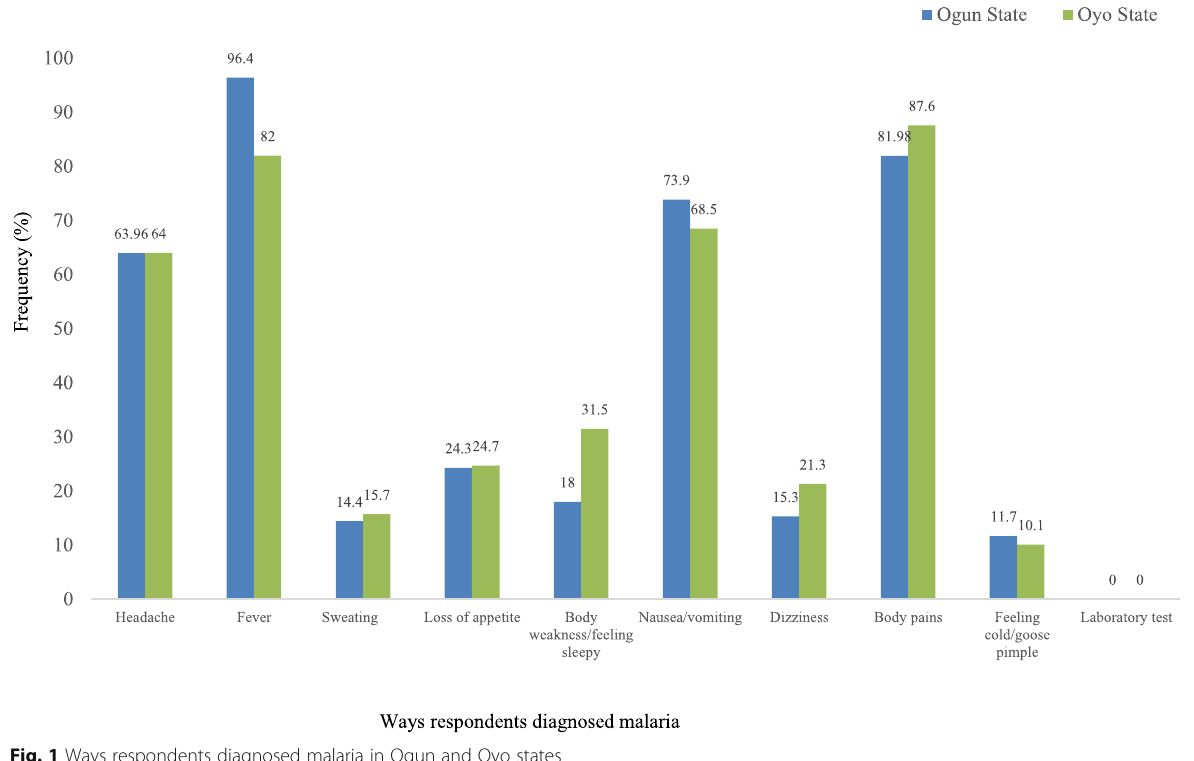
Fig. 1 Ways respondents diagnosed malaria in Ogun and Oyo states